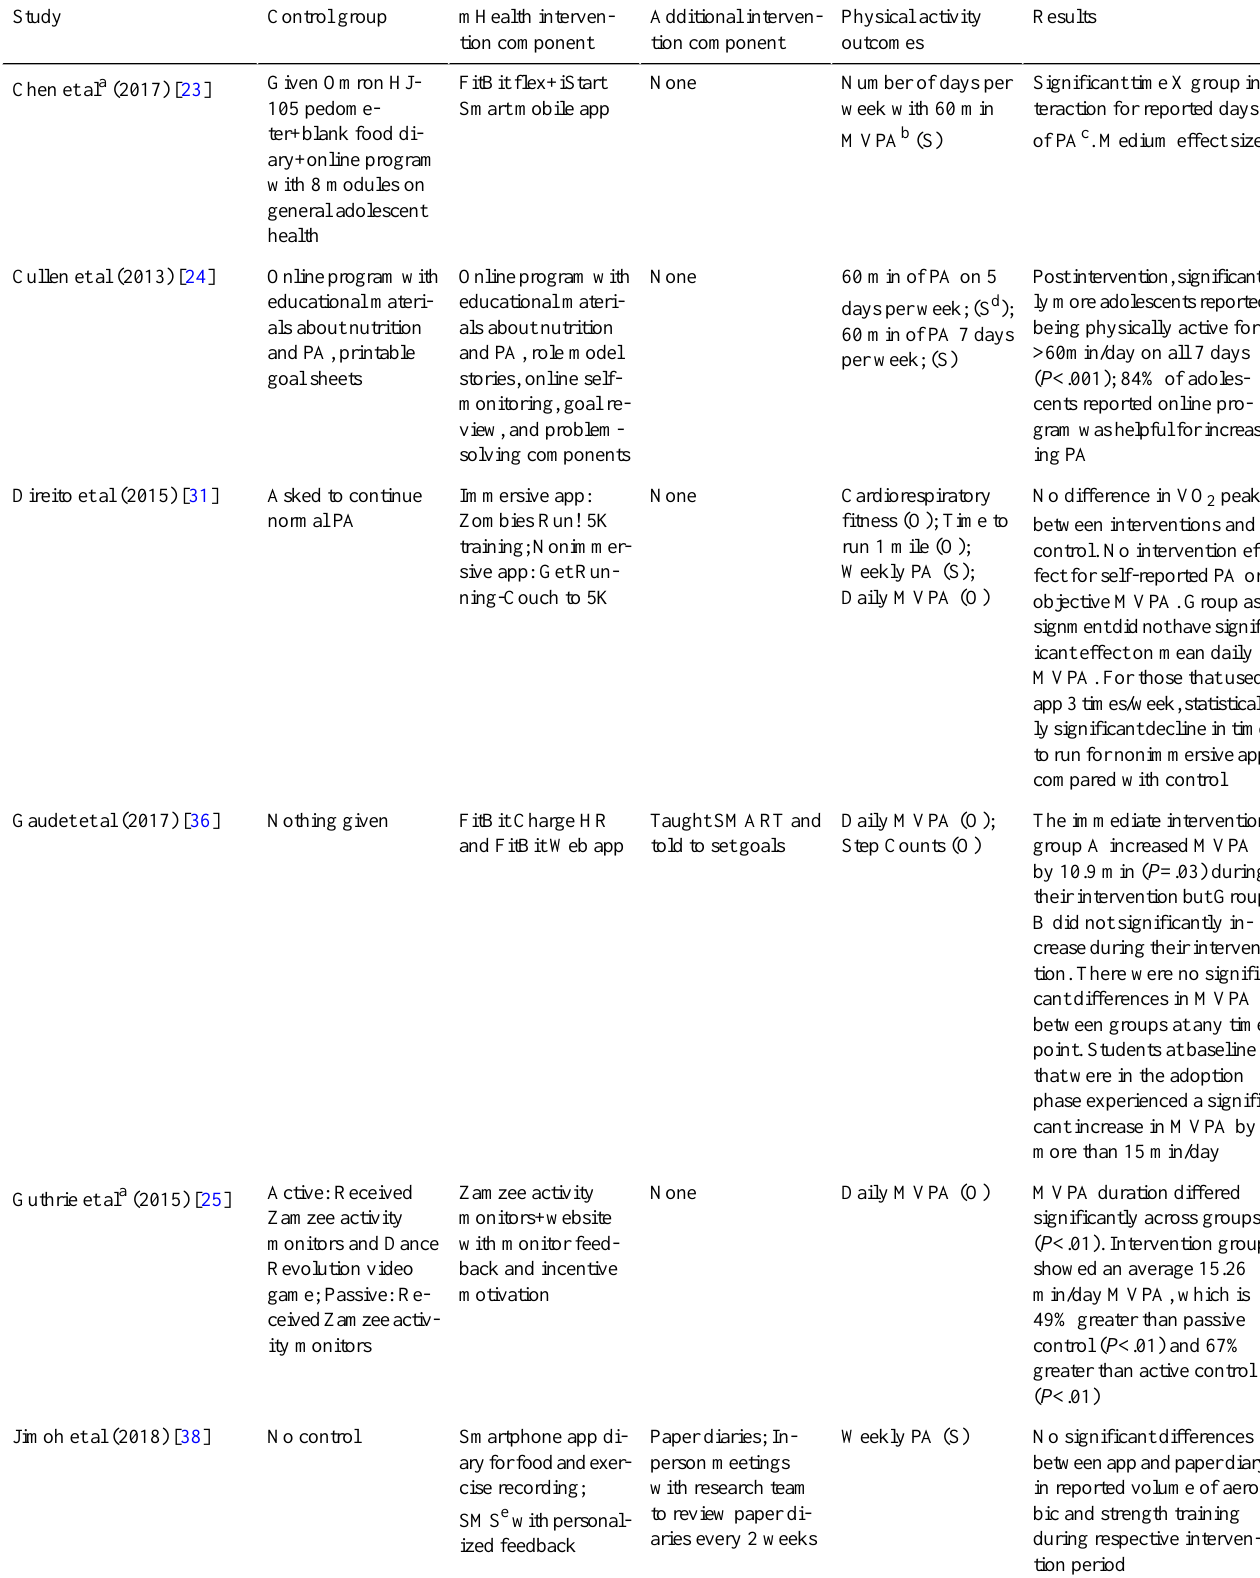
Table 2. Study components and physical activity